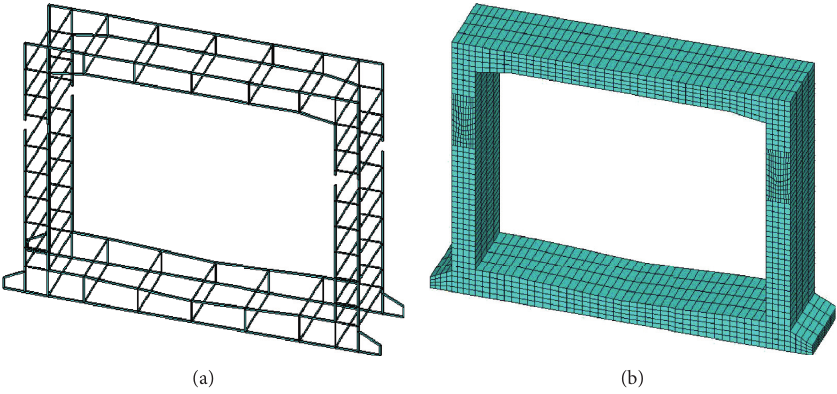
Figure 10: Finite element model of round hinged BC. (a) Reinforcement model. (b) Concrete